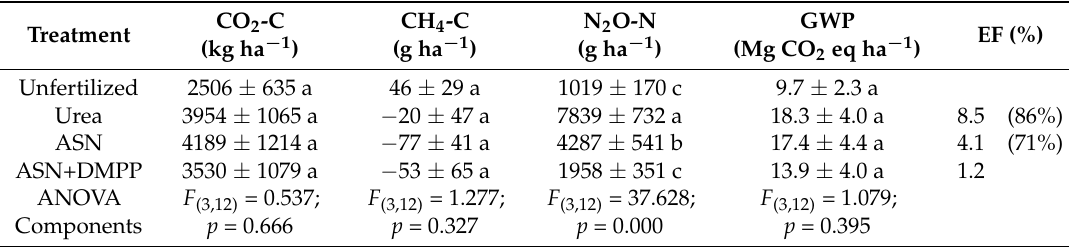
Table 2. CO 2 , CH 4 , and N 2 O cumulative emissions, global warming potential (GWP), and N 2 O emission factor (EF). In brackets: percentage of reduction of EF by ASN+DMPP. Values in cells with different letters are significantly different ( p < 0.05; n = 4).